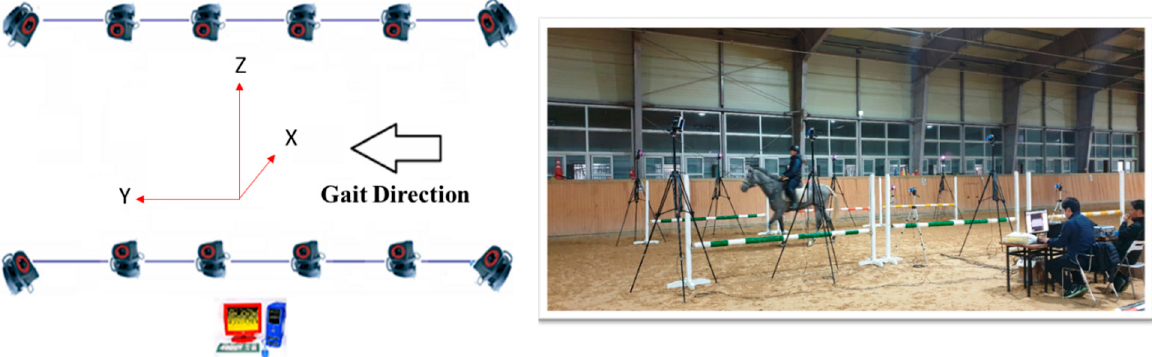
Figure 2. Experimental setting and global coordinate system.